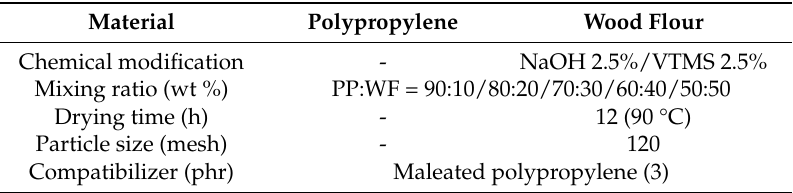
Table 1. Material preparation conditions.